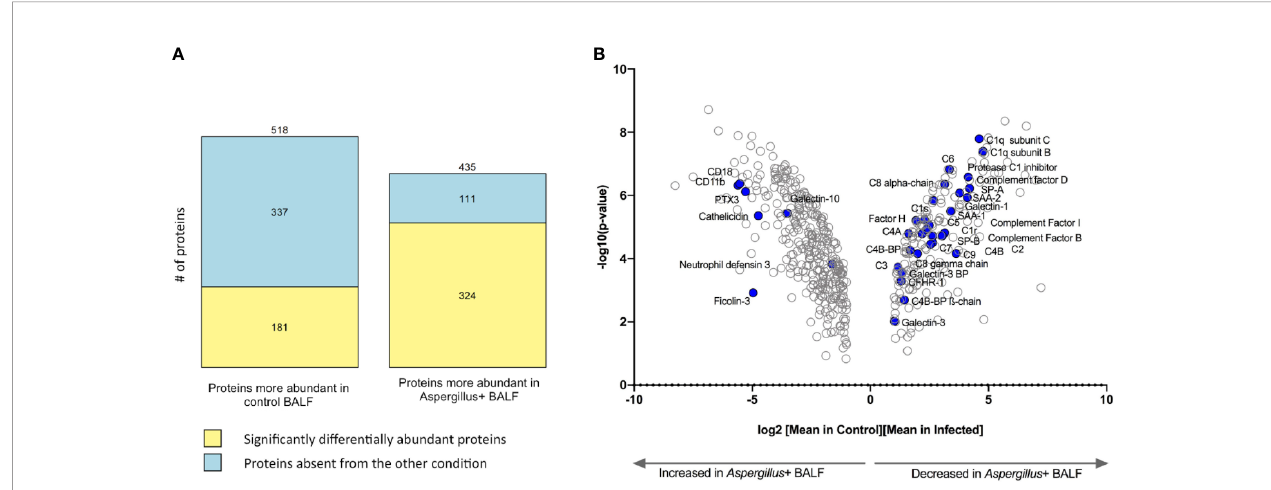
FIGURE 1 | Differentially abundant proteins in Aspergillus + bronchoalveolar lavage fl uid (BALF) as compared to control BALF. (A) Number of proteins signi fi cantly differentially abundant (yellow) or absent from the other condition (in blue) and (B) Volcano plot showing 505 proteins with log2 (fold-change) >1 between control and Aspergillus + conditions; humoral immune components majorly varying in the Aspergillus + BALF are highlighted in